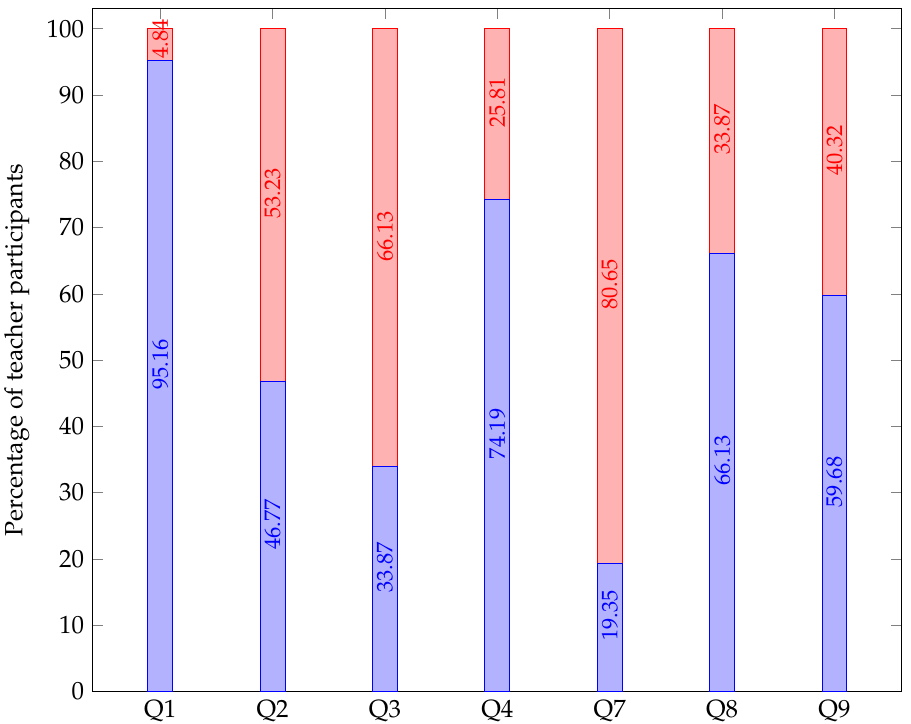
Figure 4. This figure shows the results of educators’ perceptions of and responses to student engagement in cheating. Q1–Q4 and Q7–Q9 represent Questions 1–4 and 7–9 in Table 2,